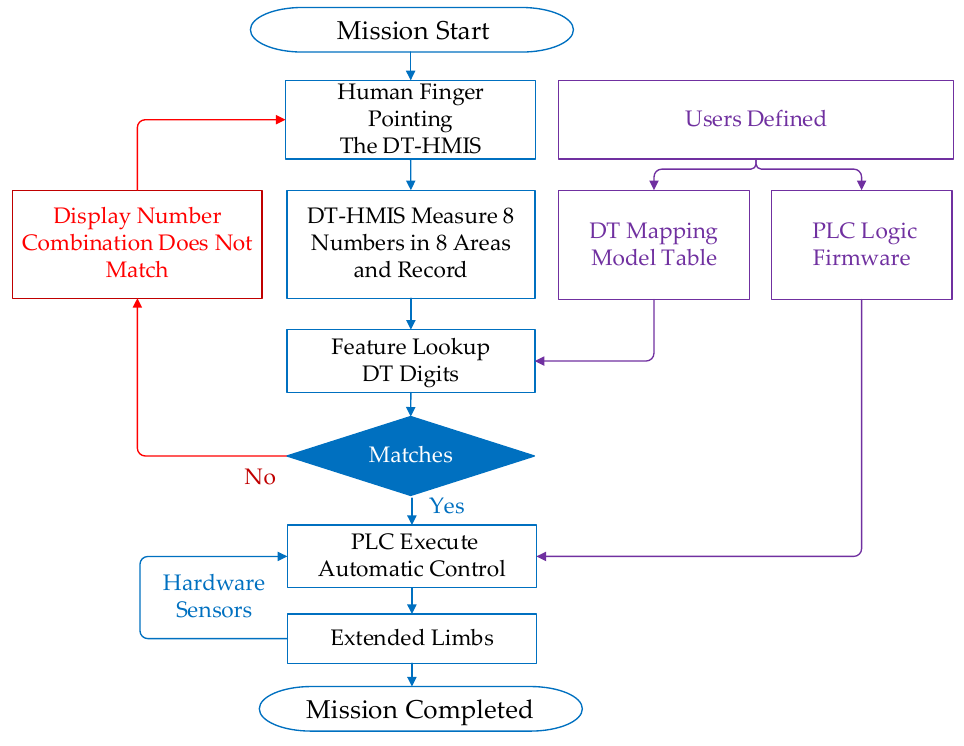
Figure 2. The DT- HMIS service and processing flow chart